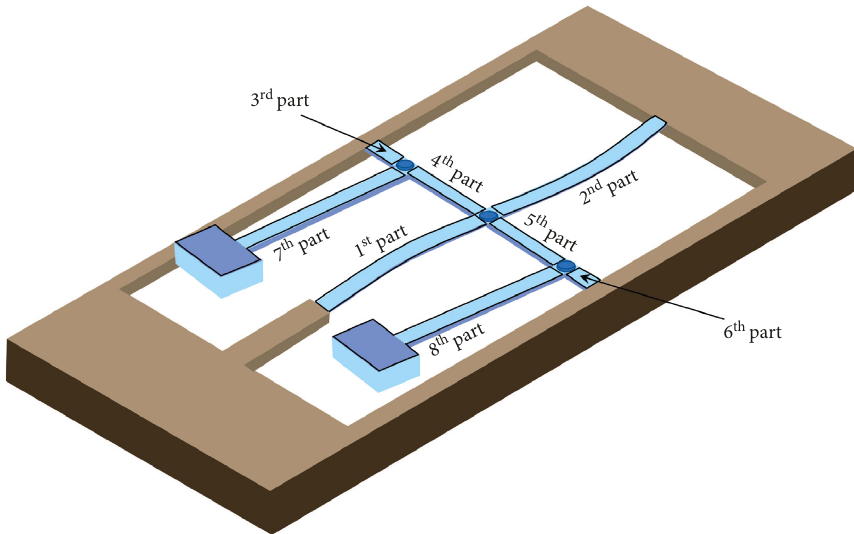
Figure 2: The coupled bistable structure divided into eight individual